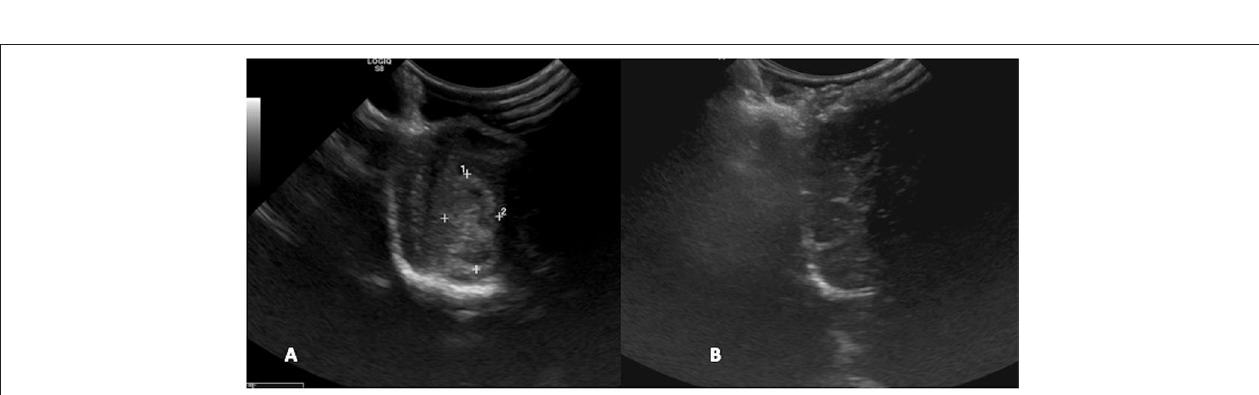
FIGURE 9 | Case 17. (A) Transverse CT image of a canine brain showing bilateral falcine meningiomas. (B) Transverse intraoperative ultrasound image of the bilateral falcine masses. Note the very close similarities in measurements on the CT and the ultrasound images (CT 2.16 and 1.96cm vs. US 2.26 and 1.96cm). (C) Transverse intraoperative ultrasound with Doppler, demonstrating the position of the dorsal sagittal sinus (DSS).